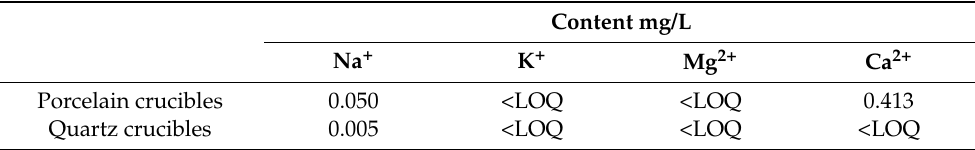
Table 2. Blanks in different